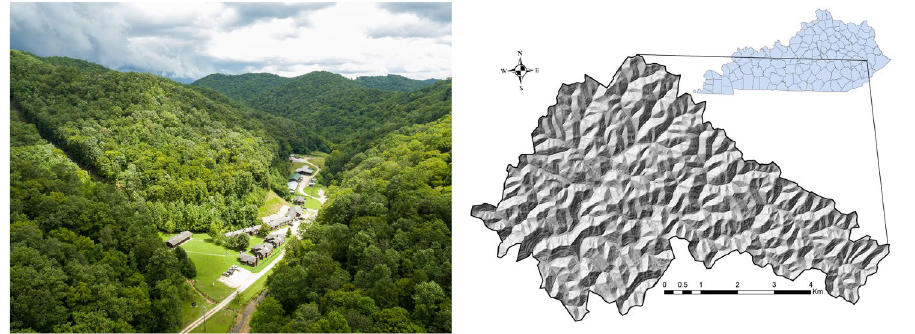
Figure 2. Aerial image of the camp and a glimpse over the canopy at Robinson Forest in Clayhole, KY ccaptured in August 2016 (credit: Matt Barton, Agricultural Communications Services–University of Kentucky); the forest’s terrain relief map and its general location within Kentucky, USA (created using ArcMap 70 version 10.2). Robinson Forest is a ~7,400-ha natural closed-canopy deciduous forest featuring a complex dissected topography and including a diverse contiguous mixed mesophytic forest made up of approximately 80 tree species.